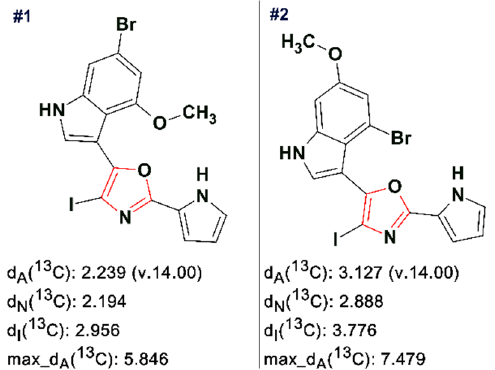
Figure 19. The two best structures of the ranked output file. The part of the structure highlighted in red is deprived of hydrogens.